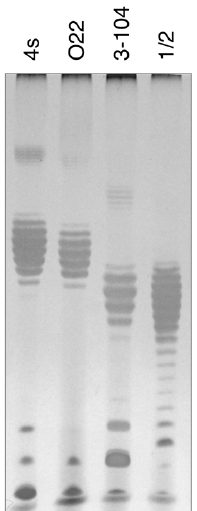
Figure 6. The SDS-PAGE analysis of LPS extracted from E. coli strains 4s (O22-like), O22, HS3-104 and HS1/2 (O81 or O81-like). It is clearly seen that the O-unit motility of HS3-104 O-antigen is distinct from all the other strains (the distances between the neighbour bands that correspond to the LPS molecules that differ by a single O-unit are slightly different that leads to the increasing phase shift between the patterns in different lanes on the gel).